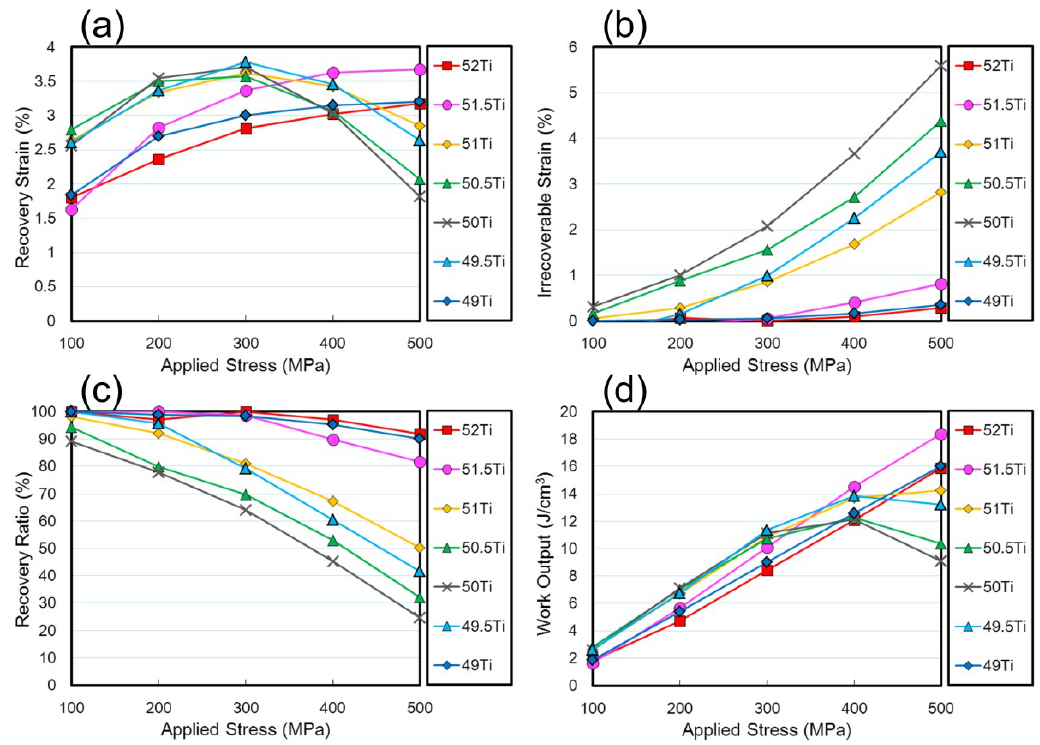
Figure 11. Evaluation of shape memory properties of the (49–52)Ti alloys. ( a ) Recovery strain; ( b ) irrecoverable strain; ( c ) recovery ratio; ( d ) work output.